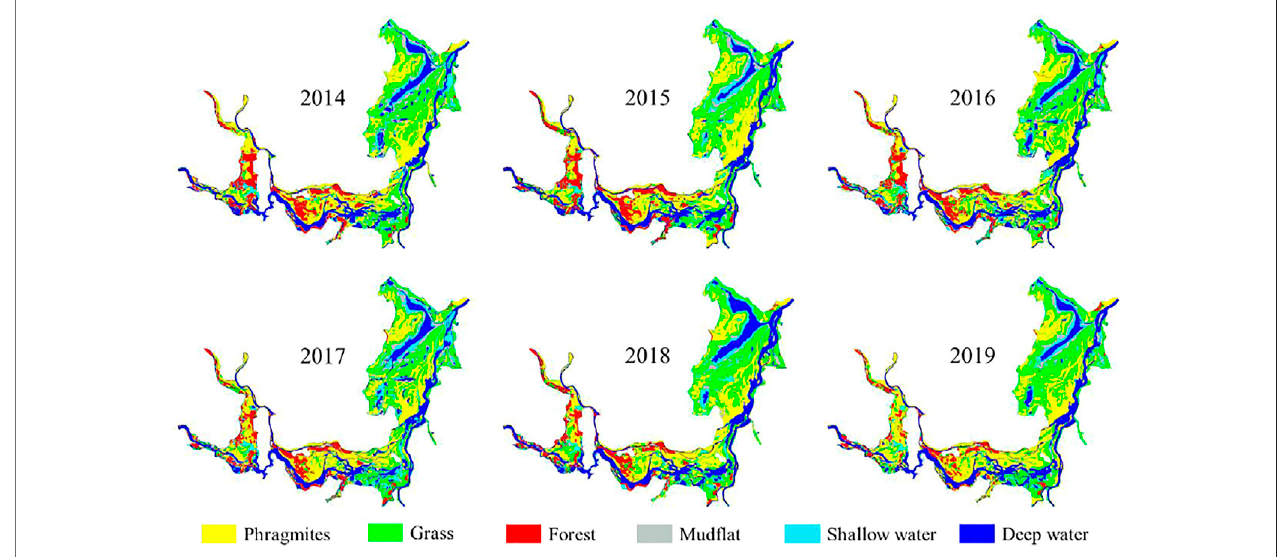
FIGURE 2 | The land cover changes of DL from 2014 to 2019 includes the 3 years before PER (2014-2016) and the 3 years after PER (2017-2019).